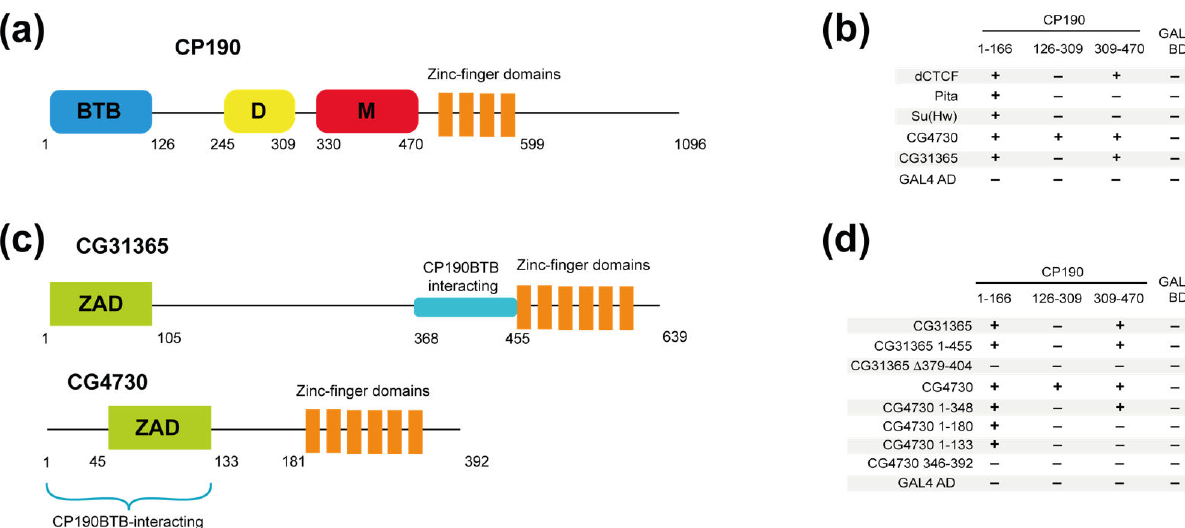
Figure 2. CP190 uses different domains to interact with C2H2 proteins. ( a ) Schematic presentation of the CP190 domain structure. ( b ) Determination of CP190 domains involved in the interaction with C2H2 proteins. ( c ) Schematic presentation of CG31365 and CG4730 domain structures with CP190 BTB domain-interacting regions depicted. ( d ) Mapping of regions in CG4730 and CG31365 that interact with CP190 in a yeast two-hybrid assay. Full-length and various fragments of CG4730 and CG31365 were fused with the GAL4-activating domain (GAL4 AD) and tested for interaction with the CP190 domains fused to the GAL4 DNA-binding domain (GAL4 BD). The growth assay yeast plates are shown in the Supplementary Materials Figure